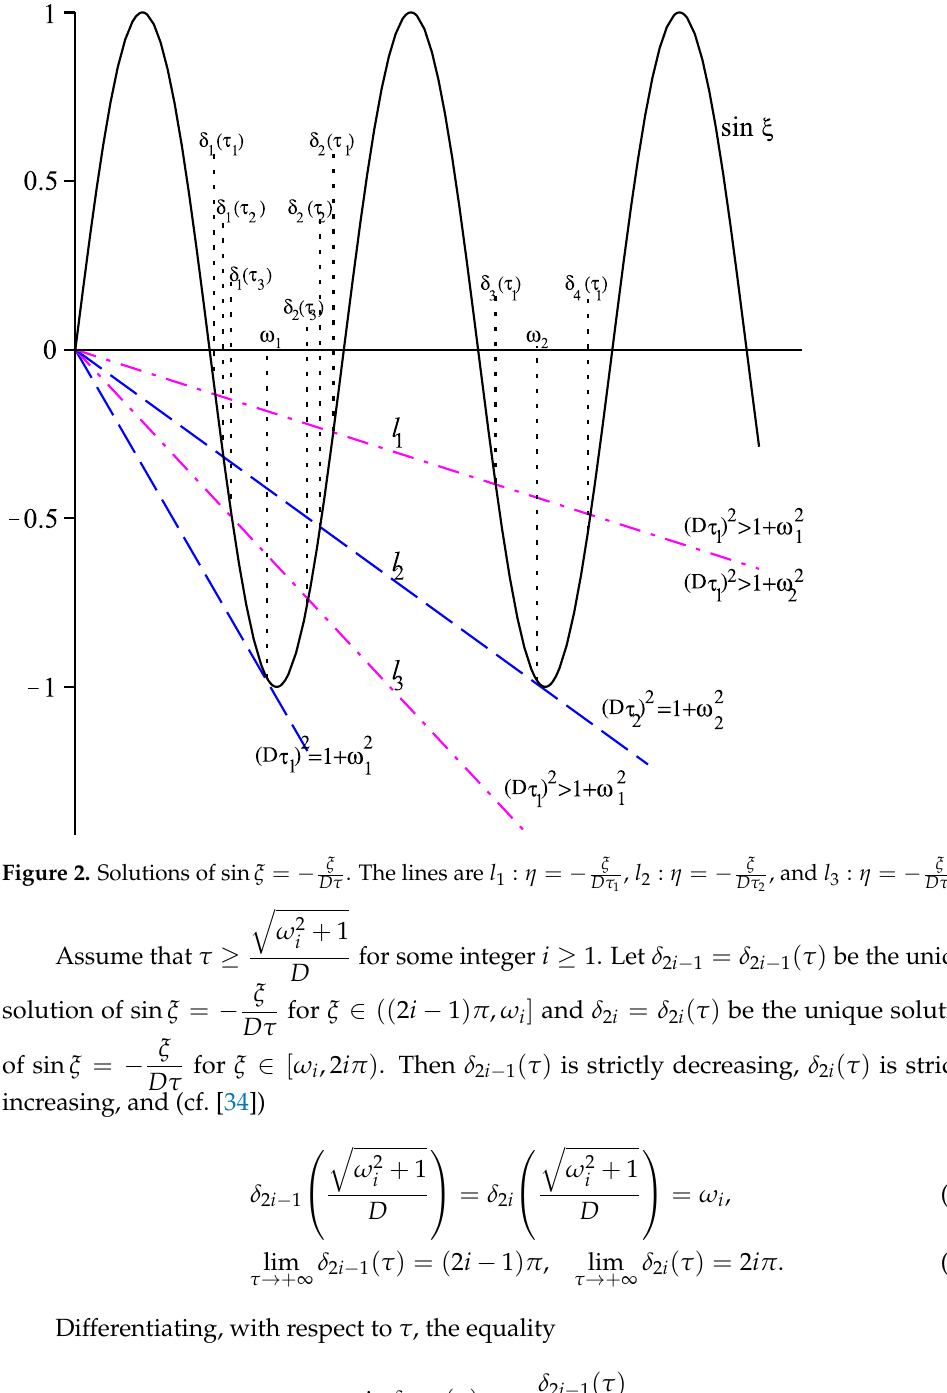
. The lines are l 1 : η = − ξ D τ